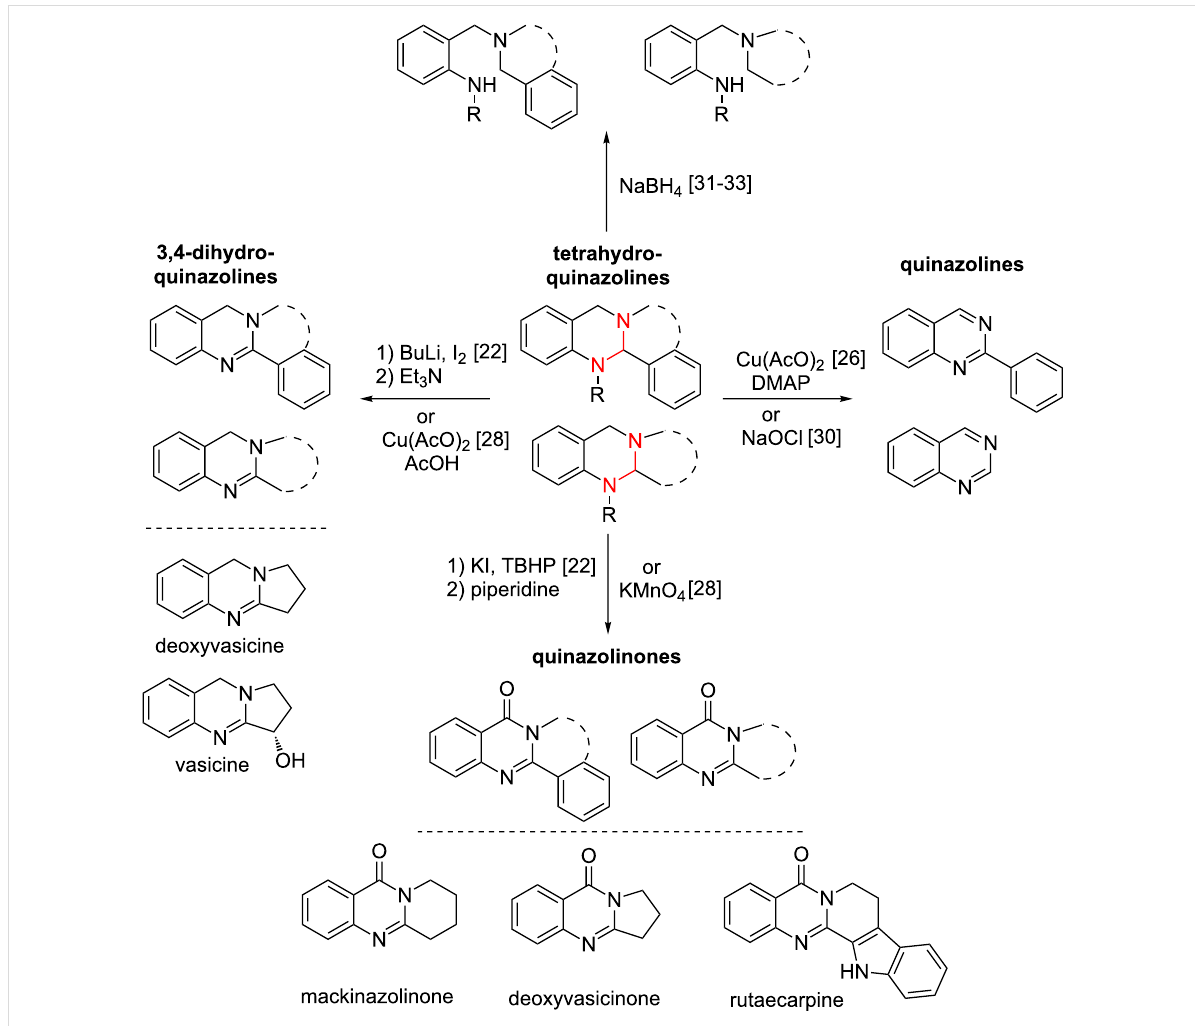
Scheme 2: Oxidation and reduction reactions of tetrahydroquinazolines. Dashed lines indicate both cyclized or non-cyclized compounds and the aminal structure is highlighted in